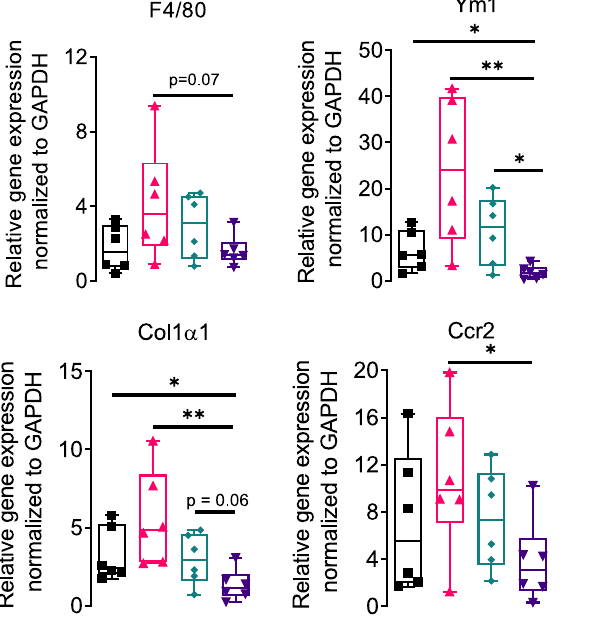
Fig. 9 | Effect of MTP-incorporated nanoliposomes on pre-metastatic niche markers. Boxgraphsshowingquantitativereal-timePCRresultsshowingtheeffect of MTP-HSPC-L, MTP-DOPS and MTP-PAPC-L on different markers for pre- metastatic niche in lungs. N =6 mice per group (left to right, Ym1: * p =0.028, ** p =0.0065, * p =0.015; iNos * p =0.027; Postn: * p =0.033, * p =0.036; Col1 α 1: * p =0.038, ** p =0.0088; Ccr2: * p =0.038; Sdf-1: * p =0.038, * p =0.016). Data